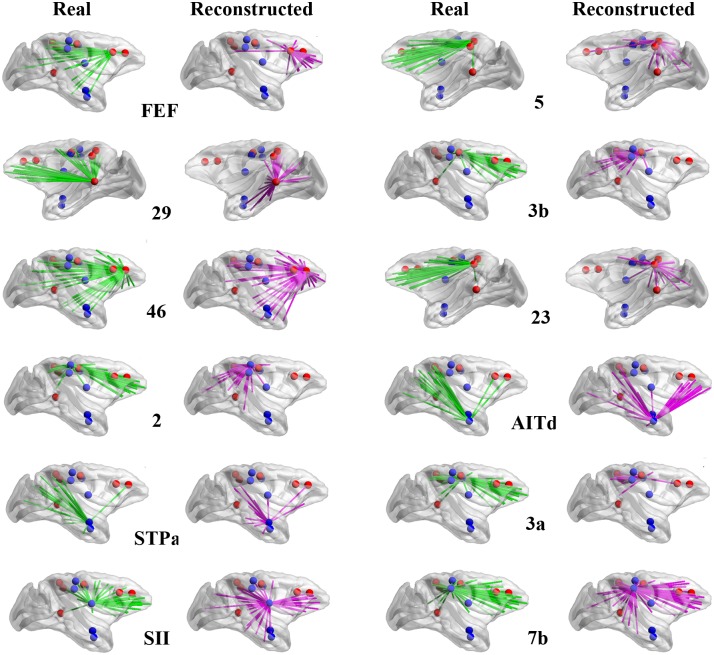
Comparison of the connections of 12 LDCs areas with ZR(i) < 1.65.The green and pink lines represent the connections of the area in the real network and the reconstructed network, respectively. The values are mapped on the cortical surface using BrainNet Viewer [81]. The name of the area is indicated in the plot. The six core LDC areas are marked in red dots, while the remaining six LDCs are marked in blue dots.